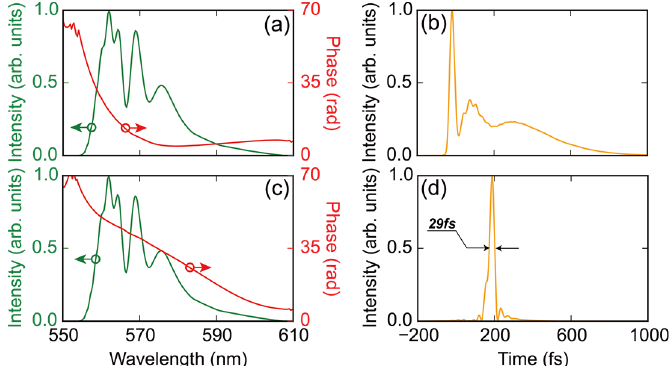
Figure 6. Plotted using the open source software Python(x,y). ( a ) The spectrum (green solid line) filtered from the output spectrum of Figure 5i by using a super-Gauss window from 550 nm to 610 nm, and the corresponding phase is marked as red solid line. After GDD and TOD compensation, the spectrum and phase are shown in panel ( c ). ( b , d ) The temporal profiles of the pulses by Fourier transforming the corresponding spectra.